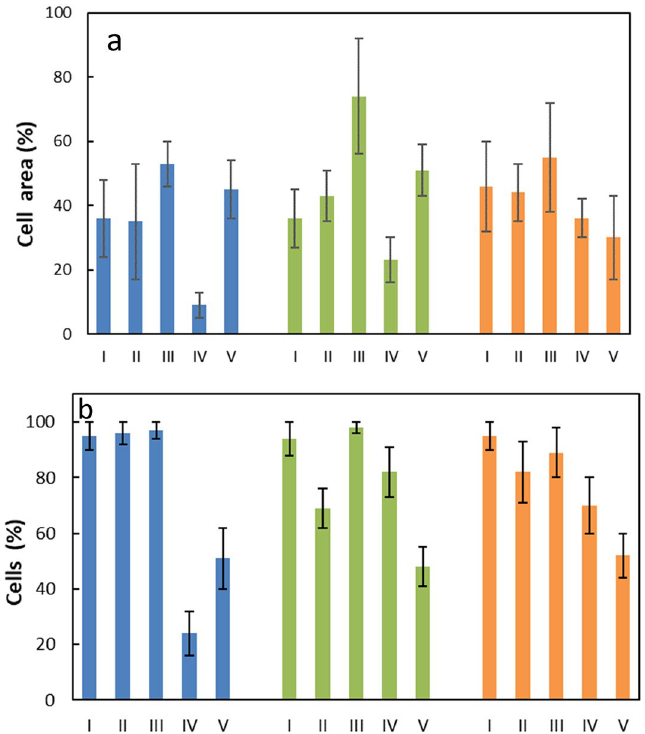
Figure 10. ( a ) HeLa (blue), HepG2 (green), and INS-1E cell area (orange) occupied by the (I) CS-UCNP, (II) CS-UCNP@Ner-PEG, (III) CS-UCNP@Ale-P(DMA-AEC)-DY-615, (IV) CS-UCNP@Ale-PDMA-DY-615,